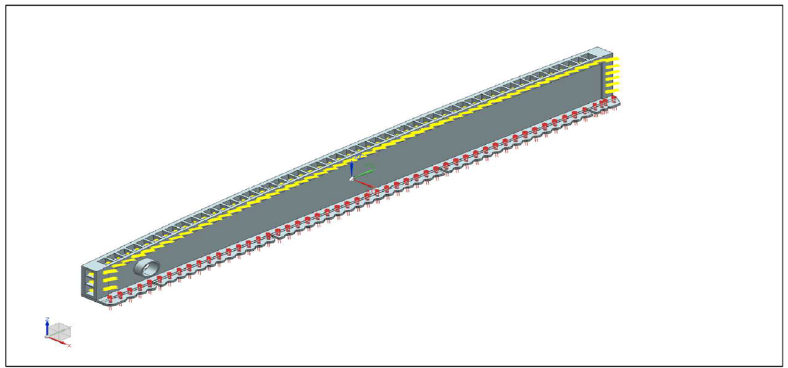
Figure 20. Boundary Conditions of wing root joint FEA.